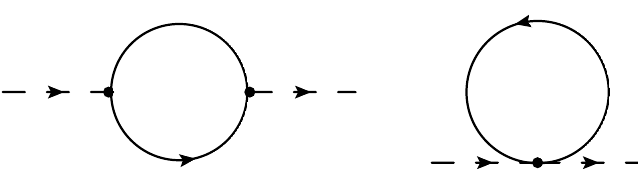
Figure 7 . Feynman diagrams contributing to the inflaton self-energy, (A.10) and (A.6), respec- tively. The dashed line represents δφ while the solid one represents N i